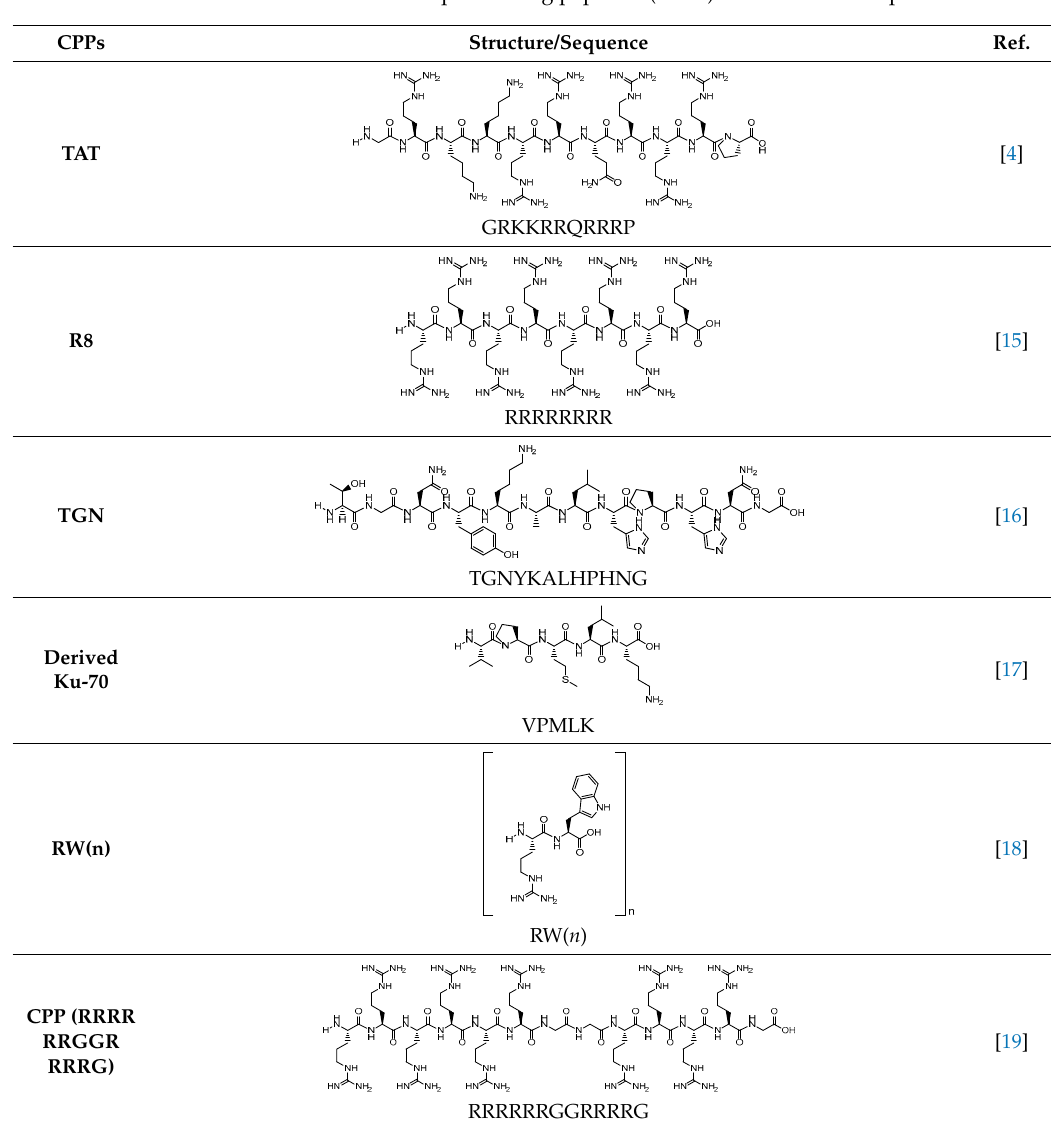
Table 1. Molecular structure of some cell-penetrating peptides (CPPs) referred to in the present